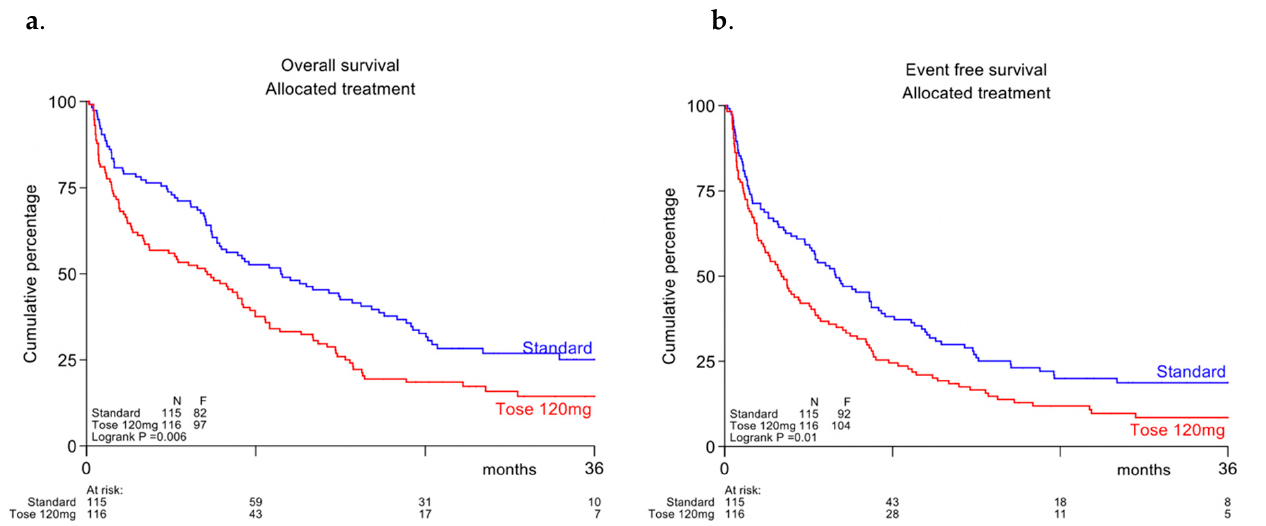
Figure 2. ( a ) Overall survival ( b ) Event-free survival. Early death rates were higher in the tosedostat arm than in the standard arm. Within 30 days, 19% of patients had died in the experimental arm, compared to 8% in the standard arm. The 60 days death rates were 28% versus 19%, respectively. See Table 2 for an overview of these results. Table 2. Treatment outcome of patients randomized to standard chemotherapy with or without tosedostat. Tosedostat HR Standard Treatment 120 mg